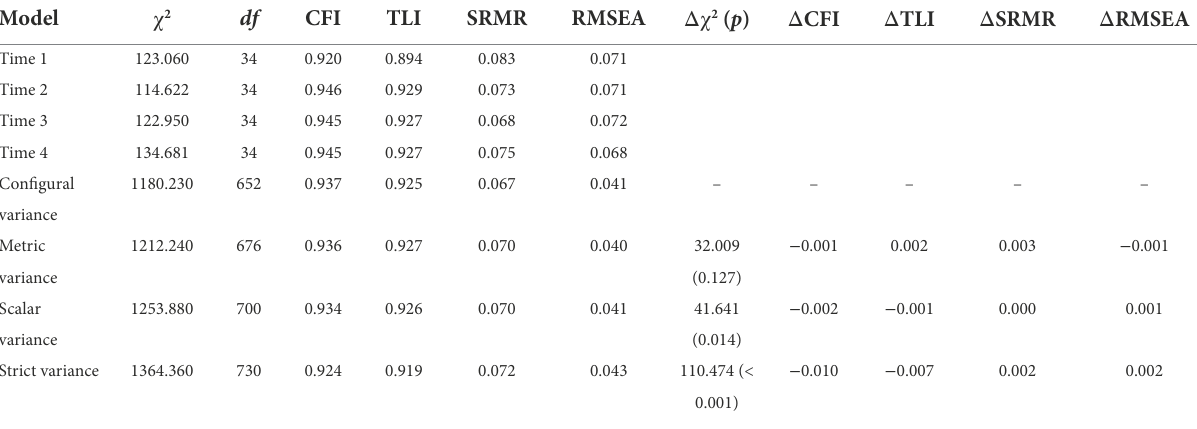
TABLE 3 Longitudinal measurement invariance model fit statistics for the MLQ.